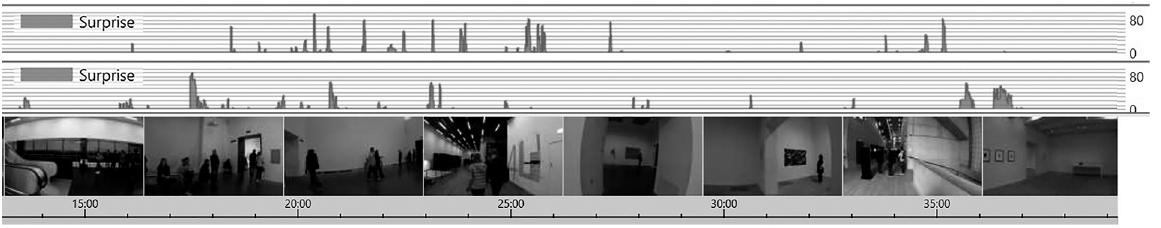
Figure 2. Output of emotional peaks in response to a stimulus.